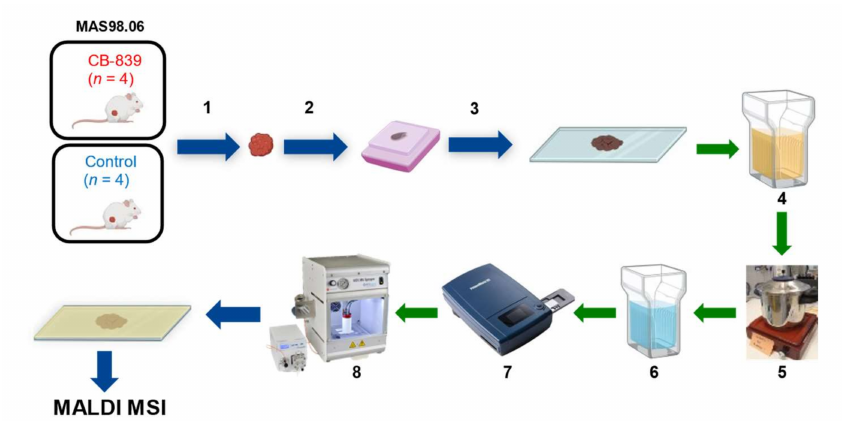
Figure 4. Sample preparation workflow for MALDI-MSI based lipidomics analysis on FFPE xenograft tissue. (1) Resection of the tumor, (2) fixation in formalin and embedding in paraffin block, (3) section- ing and mounting on conductive ITO slides, (4) solvent washing, (5) antigen retrieval, (6) hydration, (7) optical picture scanning, (8) matrix application by automatic